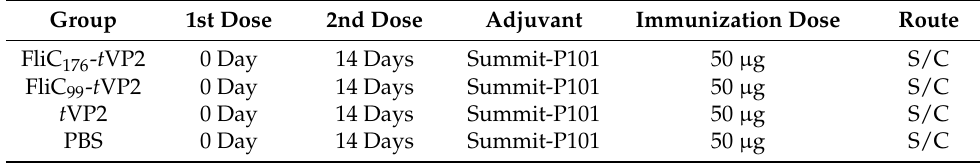
Table 2. Design of chicken